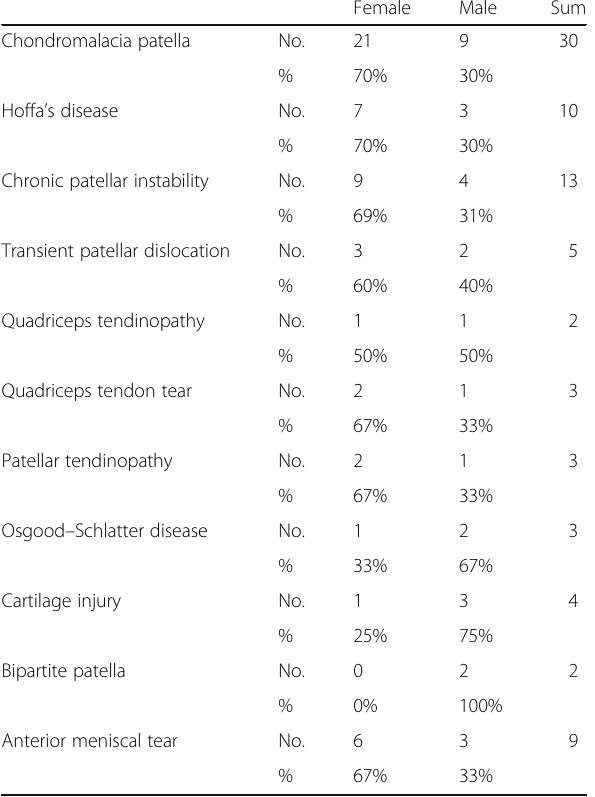
Table 8 Demonstrating the percentage of sex prevalence among different diseases entities